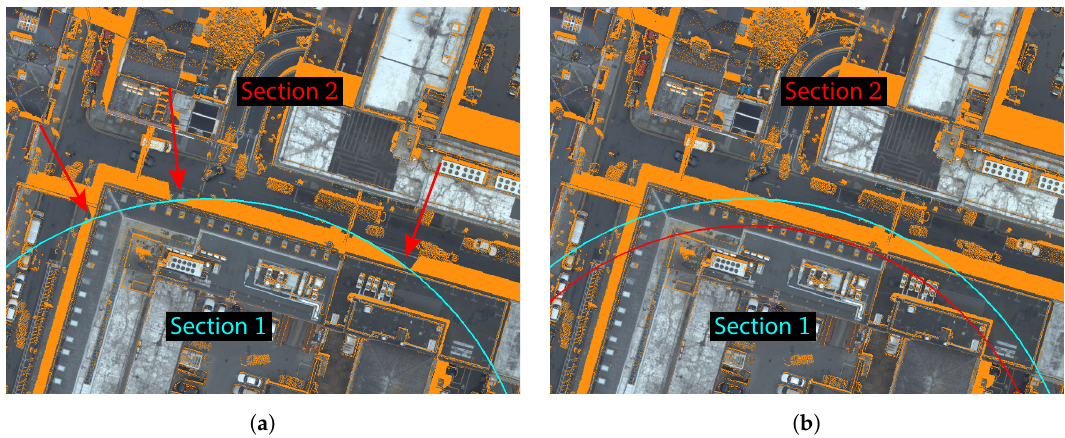
Figure 16. ( a ) False visibility at the border of two radial sections within the adaptive radial sweep method, and ( b ) considering an overlap between the radial sections to resolve the false visibility.